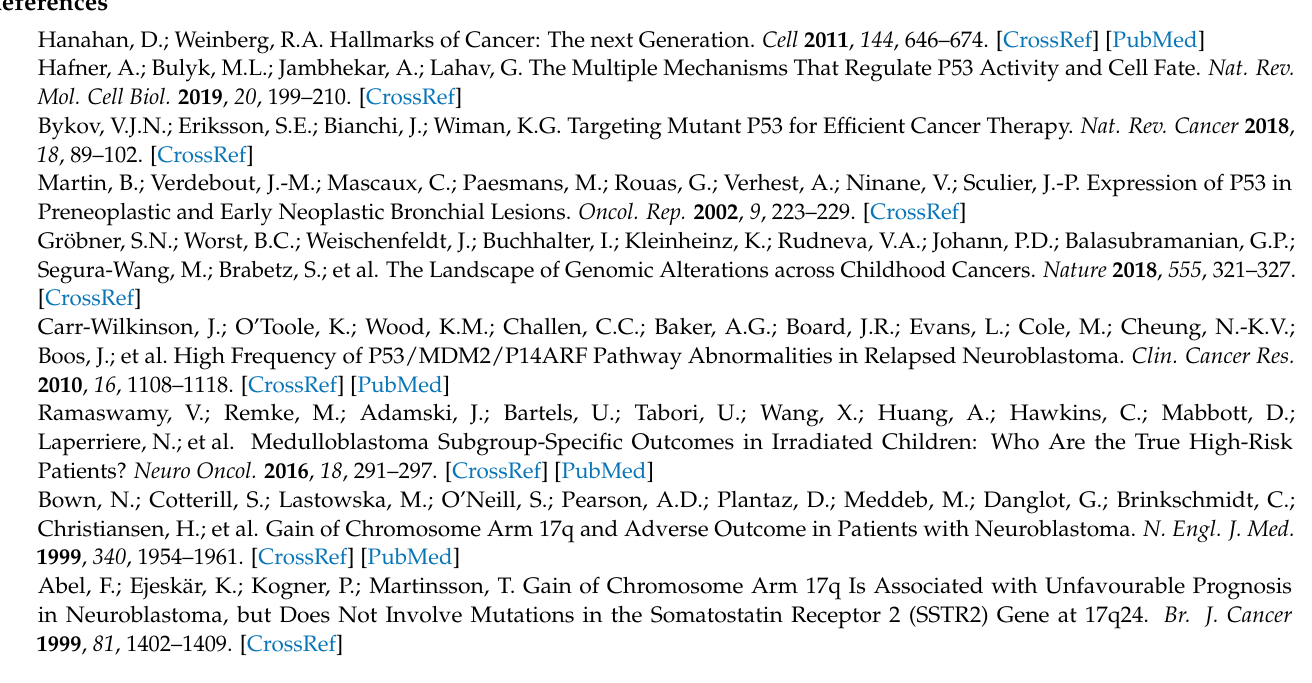
Table S2: IC50 values for WIP1 inhibitors, RITA and Nutlin-3, Table S3: TP53 mutational status in the cell lines used in the study, Table S4: List of antibodies used for Western